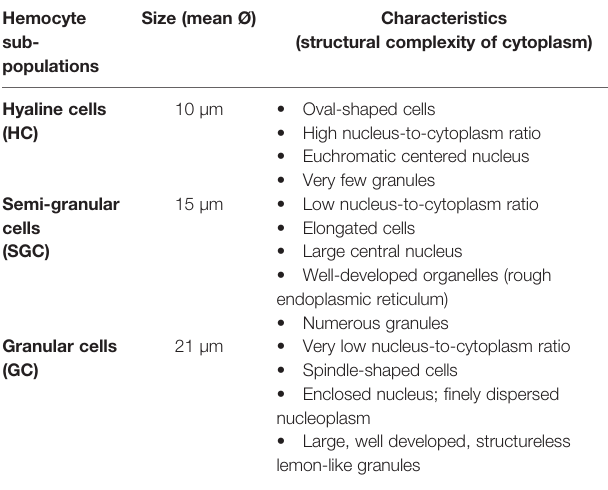
TABLE 1 | Summary of the three hemocyte sub-populations ’